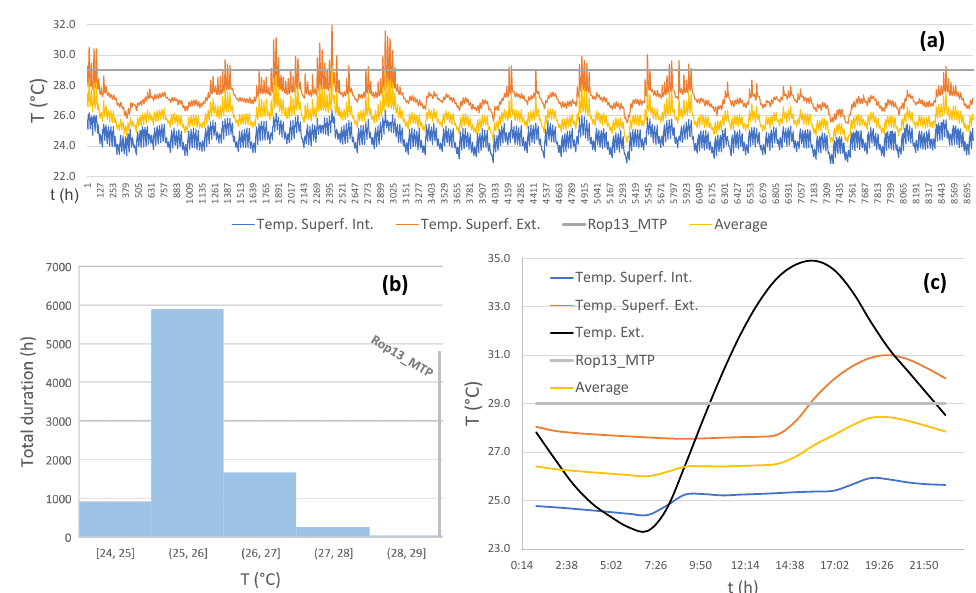
Figure 12. Local results from simulations for H060: ( a ) hourly temperatures for the entire year, ( b ) duration-based frequency for average temperature, and ( c ) hourly temperatures on 18 March.